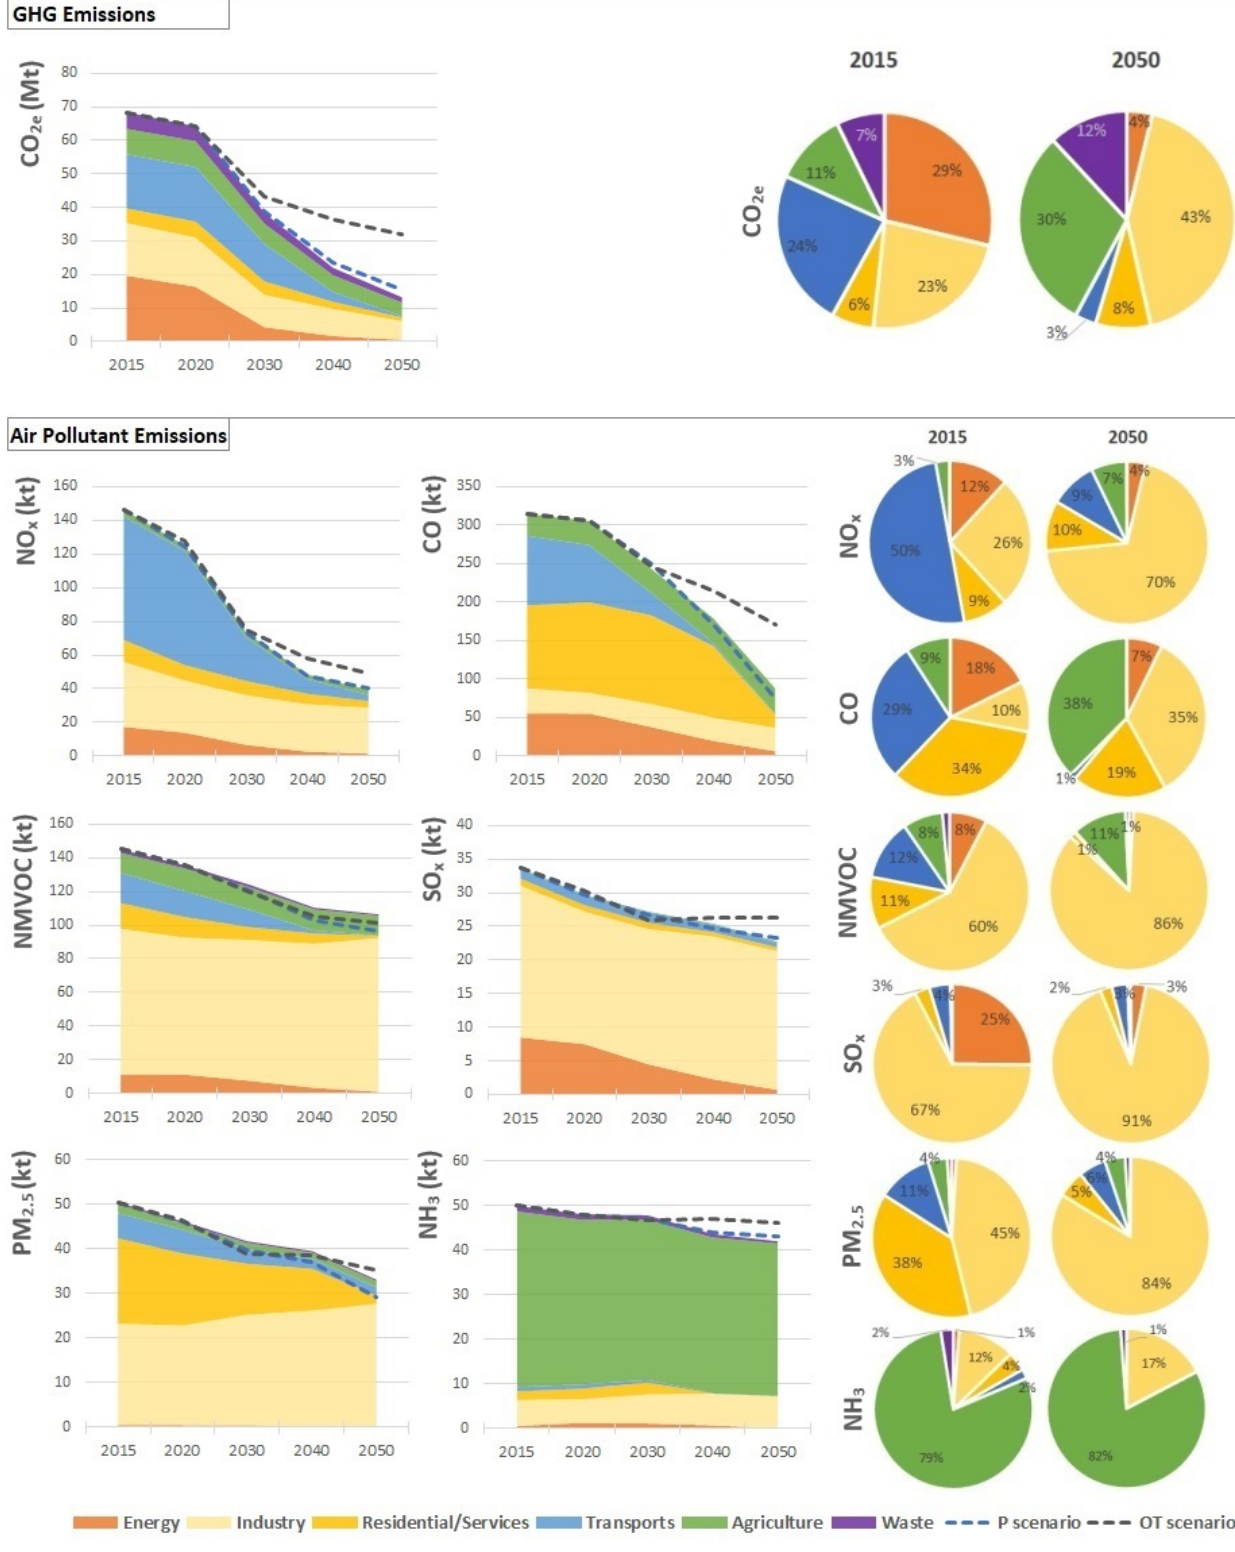
Figure 9. Sectorial contribution for total GHG and air pollutant emissions from 2015 to 2050 (pie charts represent YJ sce- nario).